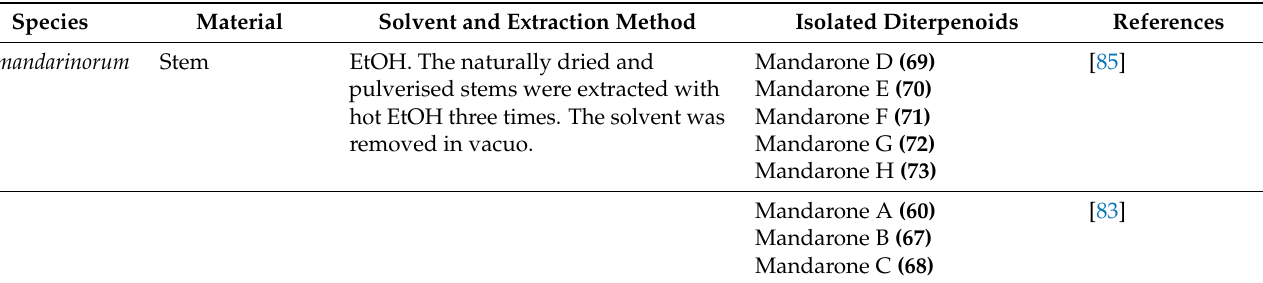
Table 9. The diterpenoid extraction method and C. mandarinorum plant material for diterpenoid